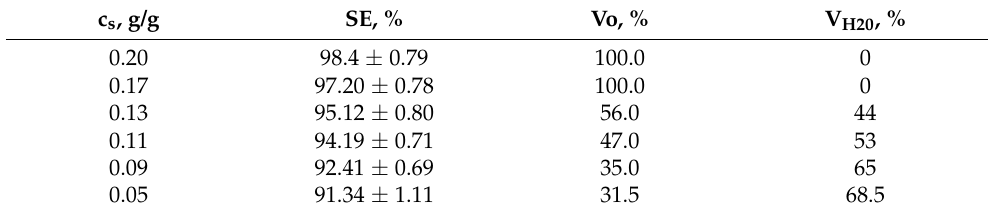
Table 4. Thermal stability (SE) of model emulsions and percentage content of water and fats after centrifugation. The values are expressed as means ± SD ( n =